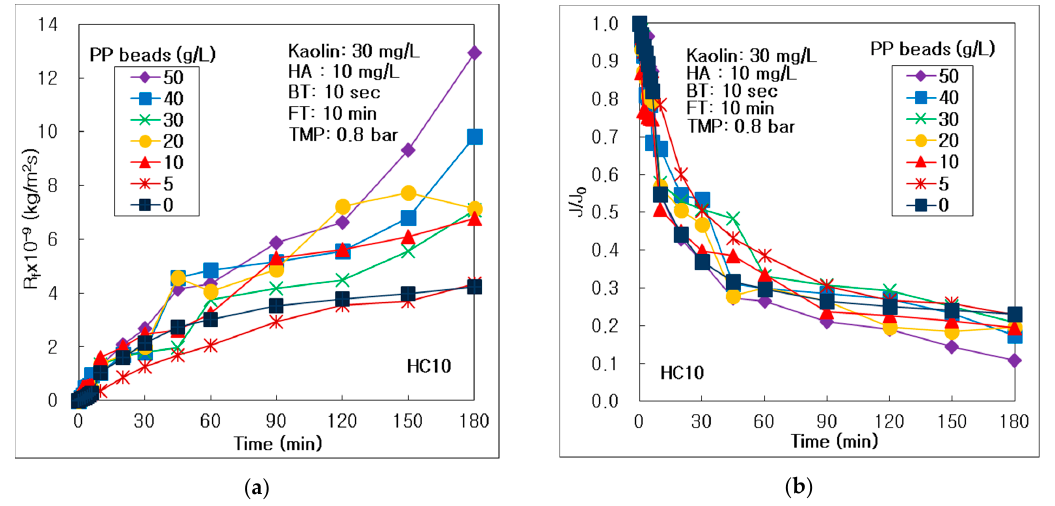
Figure 3. Effect of PP beads concentration in the hybrid process of multichannel alumina MF and PP beads with UV irradiation and periodic water backwashing: ( a ) Resistance of membrane fouling and ( b ) dimensionless permeate flux.